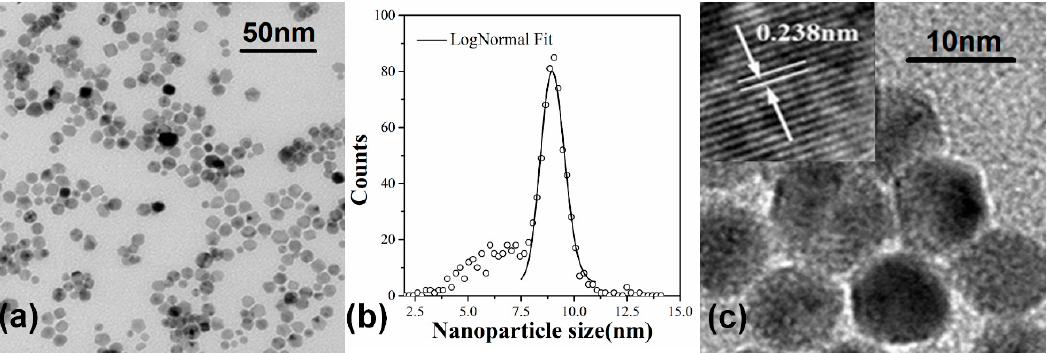
Figure 2. ( a ) A transmission electron microscope (TEM) microimage of the deposited Pd NP arrays showing a closely spaced assembling morphology. ( b ) Size distribution histogram of Pd NPs measured from the TEM image. ( c ) A high-resolution TEM image demonstrating polyhedron-shaped Pd NPs arranged in close proximity.